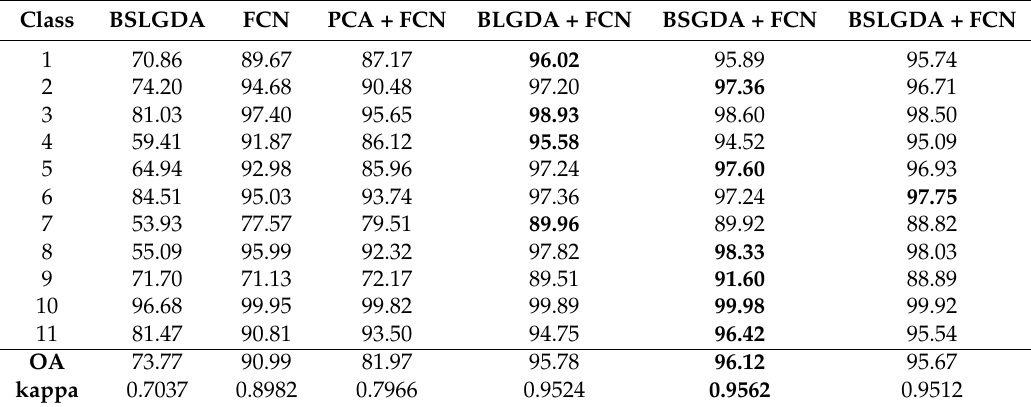
Table 1. SVM class-specific accuracy (%), OA and kappa coefficient of different methods for the Flevoland data